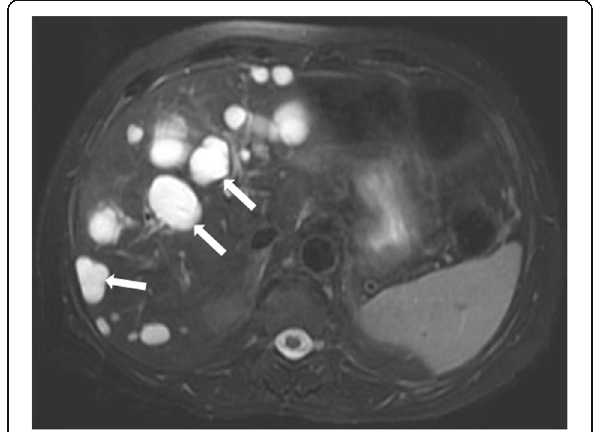
Fig. 1 A 60-year-old female patient with known long-standing PLD. Axial plane T2W fat-saturated MR image shows multiple parenchymal cysts in the liver